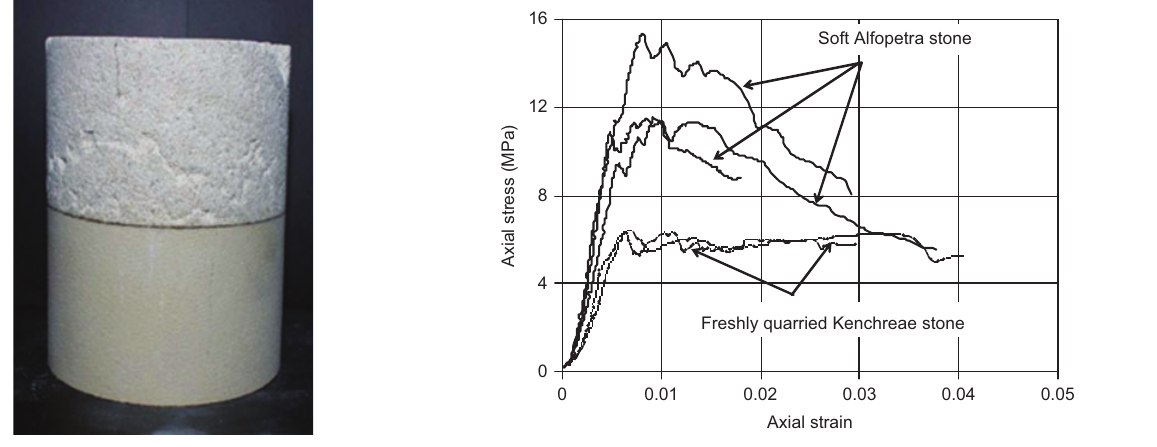
Figure 14 Cylindrical composite specimen subjected to compres- sion made from two equal halves with horizontal joining plane.